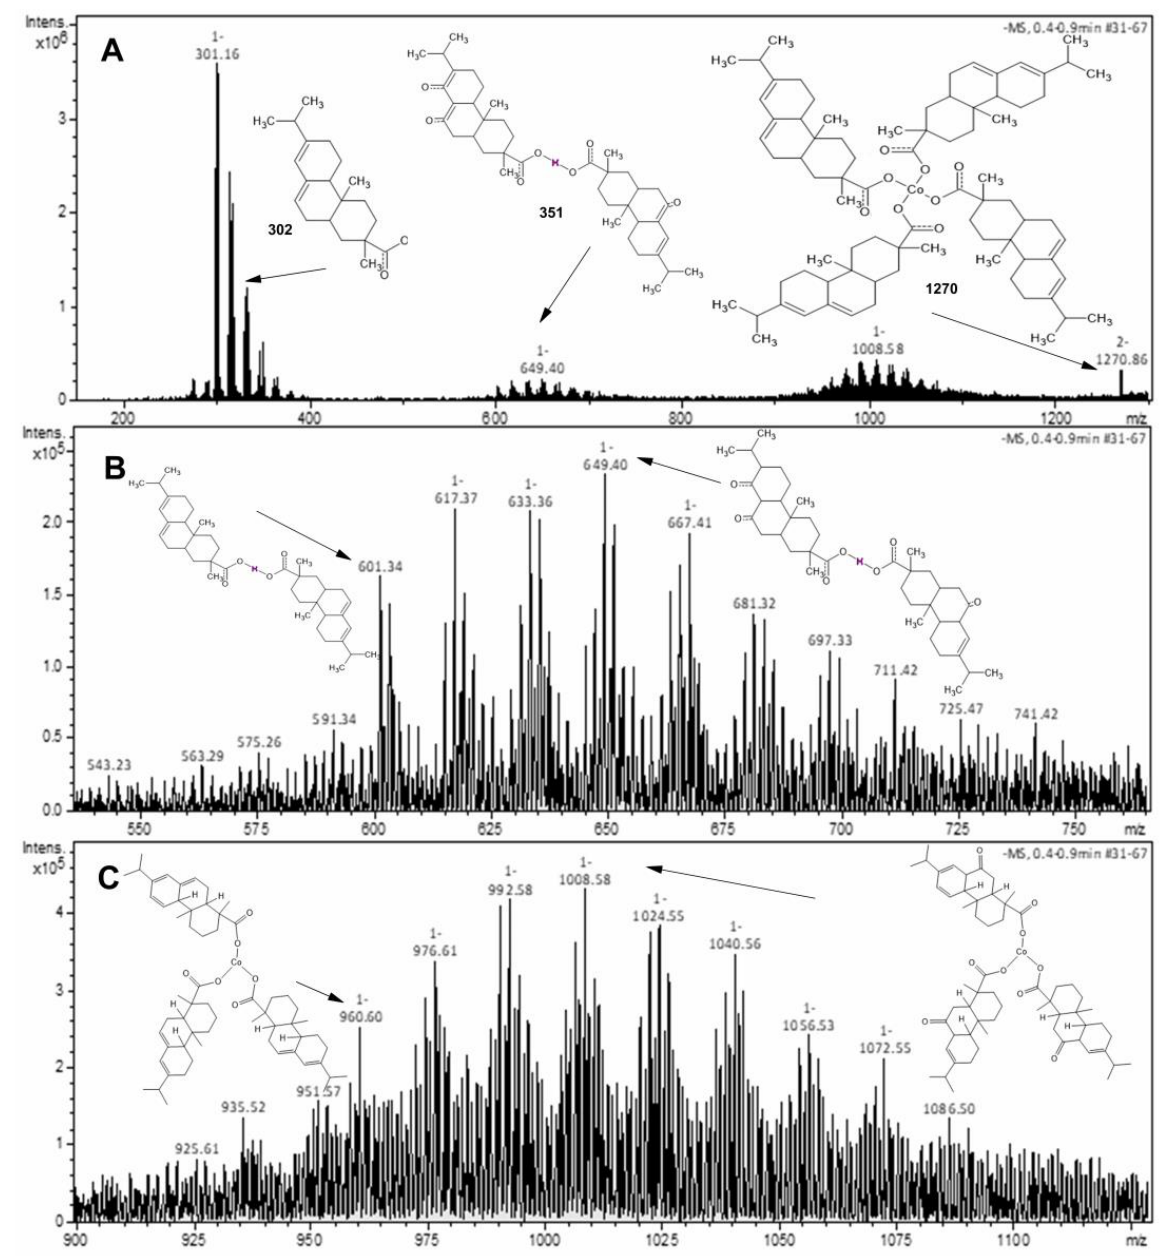
Figure 2. Mass spectra of the Co-abietate. ( A ) peaks corresponding to the theoretical molecular mass of deprotonated abietic acid, the dimeric form of the abietic acid with three additional oxygen atoms corresponding to oxidations of three C=C bonds to its keto form; the formation of Co-abietate with three abietate ligands with three additional oxygen atoms; and the formation of the Co-abietate complex with four abietate ligands at m / z 301, m / z 649, m / z − 1008, m/z − 1270, respectively. ( B ) The dimeric form of the abietic acid with three additional oxygen atoms from consecutive oxidations of C=C bonds, resulting in a difference of m / z 16 between at m / z − 617; m/z − 633; m/z − 649. ( C ) The peak of m/z − 1008 corresponds to Co-abietate formation encompassing three abietate ligands, with three C=C bonds from the ligand oxidated to the keto form.